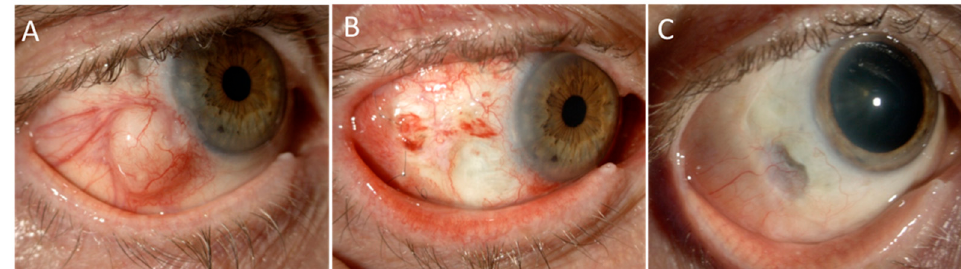
Figure 4. Ruthenium brachytheraphy for invasive squamous cell carcinoma of the conjunctiva. Part ( A ): A 71 year-old man affected by invasive squamous cell carcinoma of the conjunctiva in the right eye that aggressively recurred shortly after a partial excision with scleral lamellectomy and cryotherapy done at a local hospital. In the attempt to save the globe, he was treated with surgical excision, Ruthenium-106 brachitherapy, and ocular surface reconstruction with amniotic membrane graft. Part ( B ): One-month after surgery, the amniotic membrane had been completely reabsorbed and the patient was treated with two courses of adjuvant 5-FU and intensive topical lubrification and soft steroids with slow tapering. Part ( C ): Two years after treatment, the eye is preserved with a 20/20 vision with no signs of recurrence. Note the scleral thinning, well covered by tenon and conjunctiva, in the area of previous full-thickness tumour invasion. This area is being monitored by means of anterior segment optical coherence tomography to exclude its evolution. In such case, a wide scleral patch would be indicated.